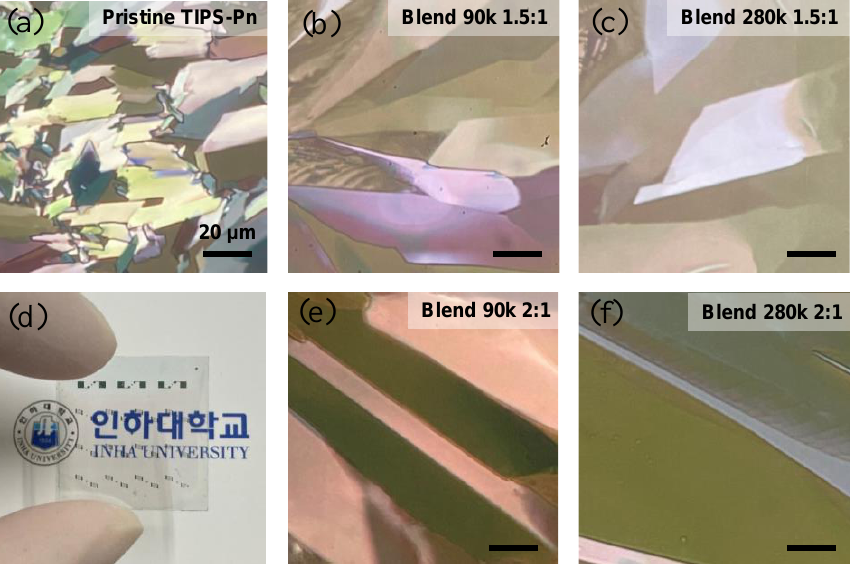
Figure 3. Polarized optical microscope images of spin-coated ( a ) pristine TIPS-Pn, ( b , e ) TIPS-Pn/PS (90,000 MW) blend, and ( c , f ) TIPS-Pn/PS (280,000 MW) blended films with blend ratios of ( b , c ) 1.5:1 and ( e , f ) 2:1, and ( d ) an optical image of the Blend 280 k 2:1 TFTs.